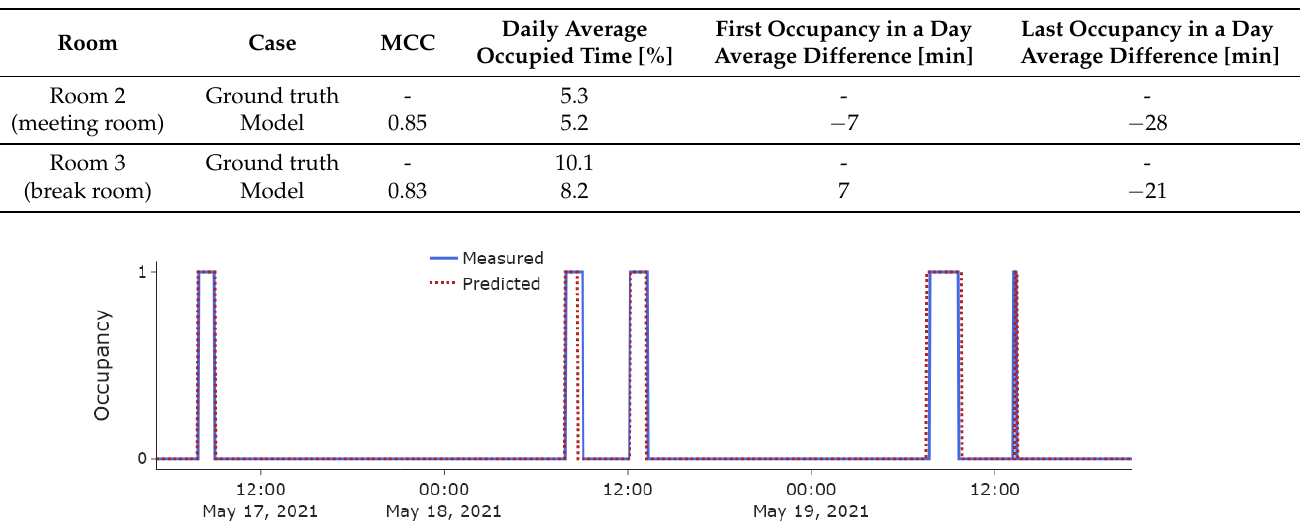
Table 6. Performance of target model on the two similar rooms (to the target room) in the same building.